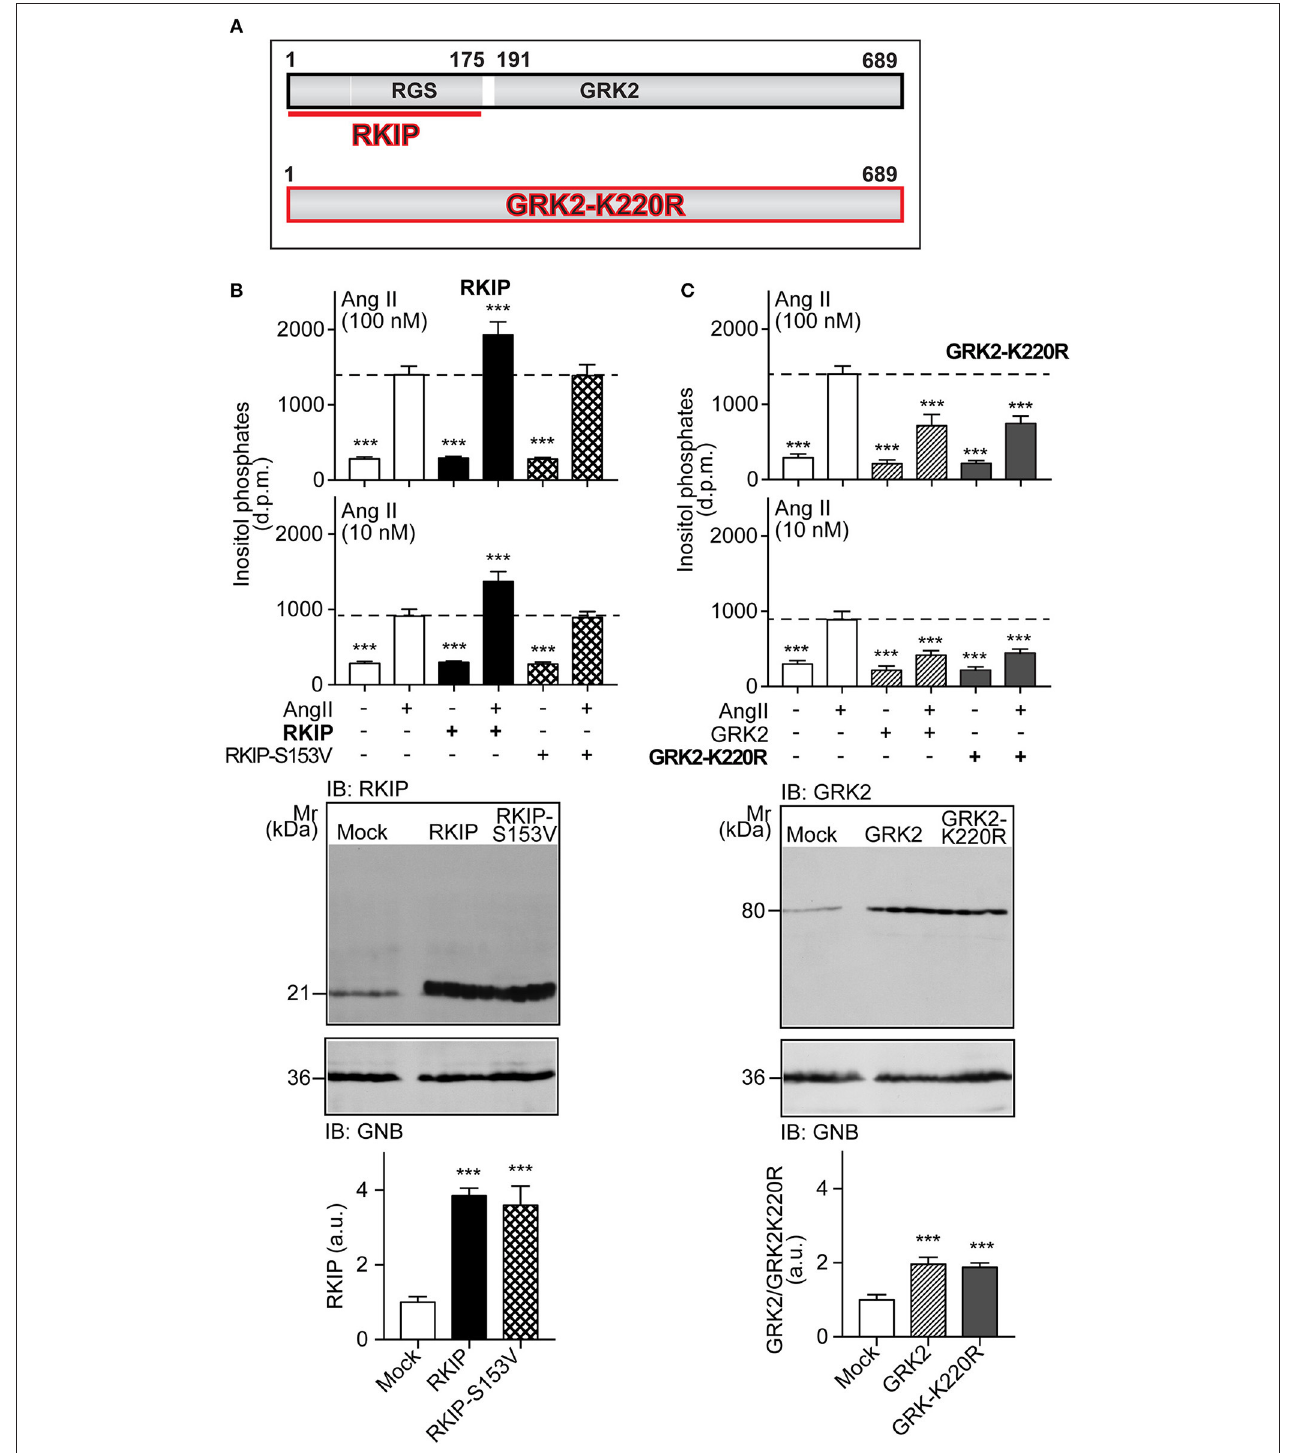
FIGURE 1 | RKIP promotes AT1 receptor sensitization whereas GRK2-K220R inhibits AT1-stimulated signaling. (A) Scheme of GRK2 and the amino-terminal RKIP interaction site (upper panel) compared to the dominant-negative GRK2-K220R mutant (lower panel). (B,C) Total inositol phosphate levels of AT1 receptor-expressing HEK cells stimulated without (–) or with ( + ) angiotensin II (100 and 10nM) and transfected without (–) or with ( + ) RKIP and RKIP-S153V (B) , or GRK2 and GRK2-K220R (C) as indicated (upper panels). Data are expressed as mean ± s.d. ( n = 8; *** p < 0.001 vs. column 2; Tukey’s test).The lower panels show immunoblots, which detect RKIP (B) and GRK2 (C) proteins of HEK cells expressing the indicated proteins Immunoblot detection of GNB was used as a loading control ( ± s.d.; n = 4; *** p < 0.001 vs. mock; Tukey’s test). See also Supplementary Figures 1A,B .